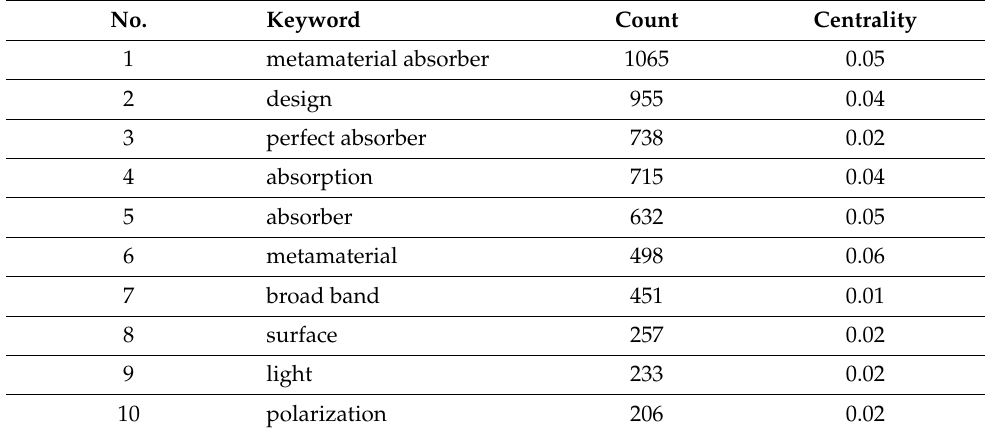
Table 4. The top ten keywords in the research area of metamaterial absorbers.